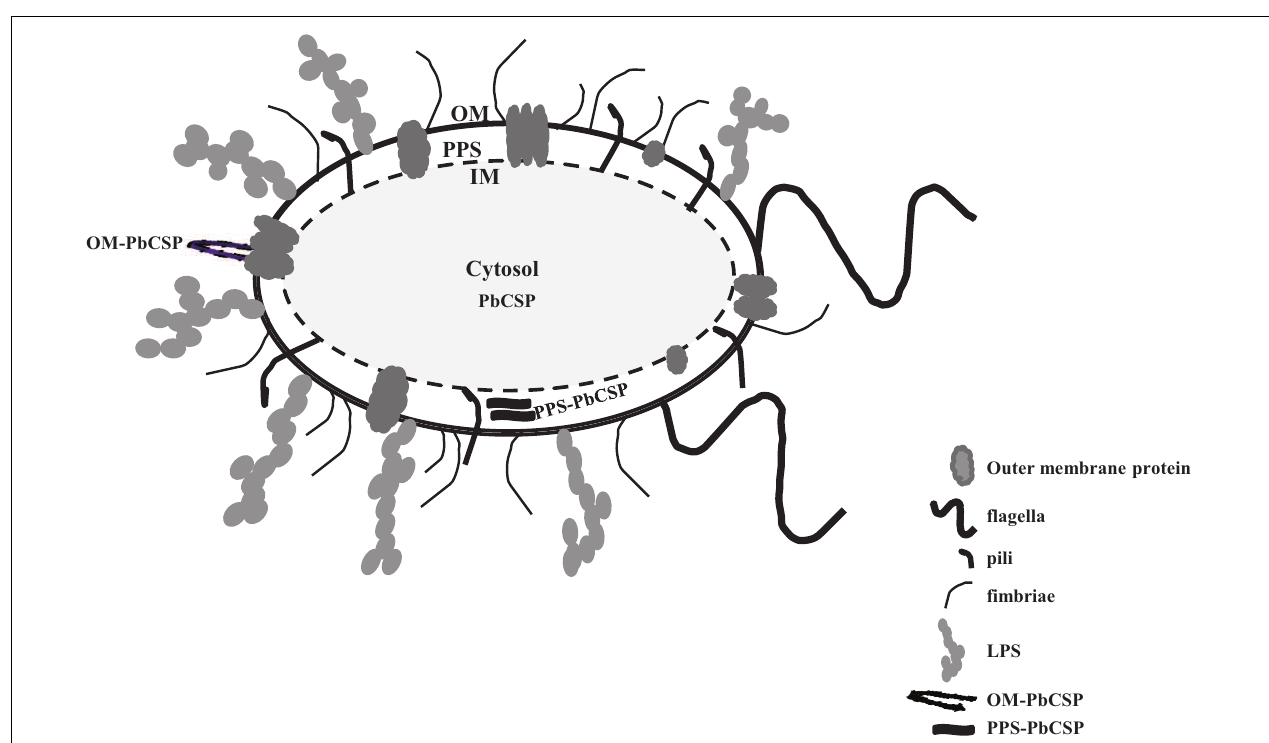
periplasmic space with MBP Inner membrane (IM). Cartoons of various cell surface molecules are included but not drawn to scale, for instance pili, flagella, LPS, and transmembrane